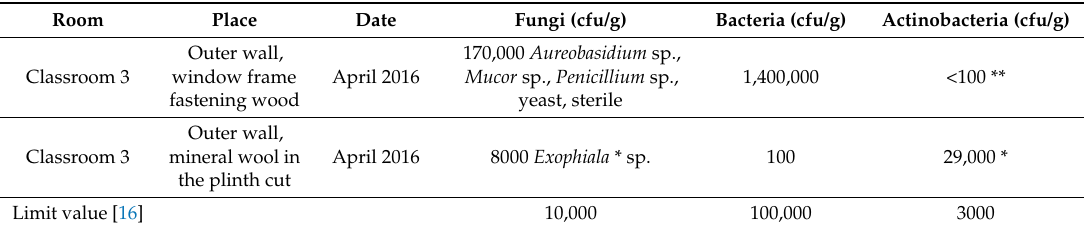
Table 1. Microbial growth in outer wall structures of Classroom 3